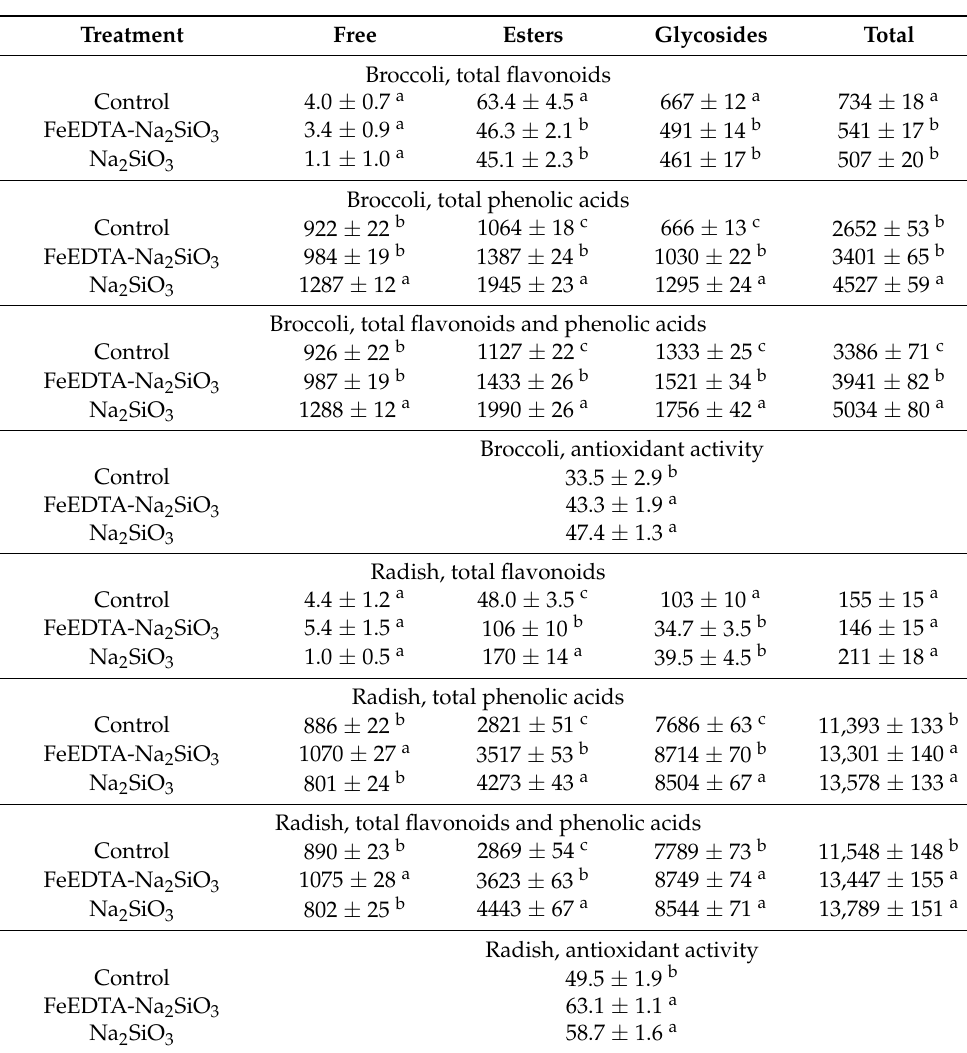
Table 5. The total content of phenolic acids and flavonoids ( µ g/g DW) and antioxidant capacity (Trolox equivalent, µ M/g DW) in broccoli and radish sprouts treated with elicitors during growth.